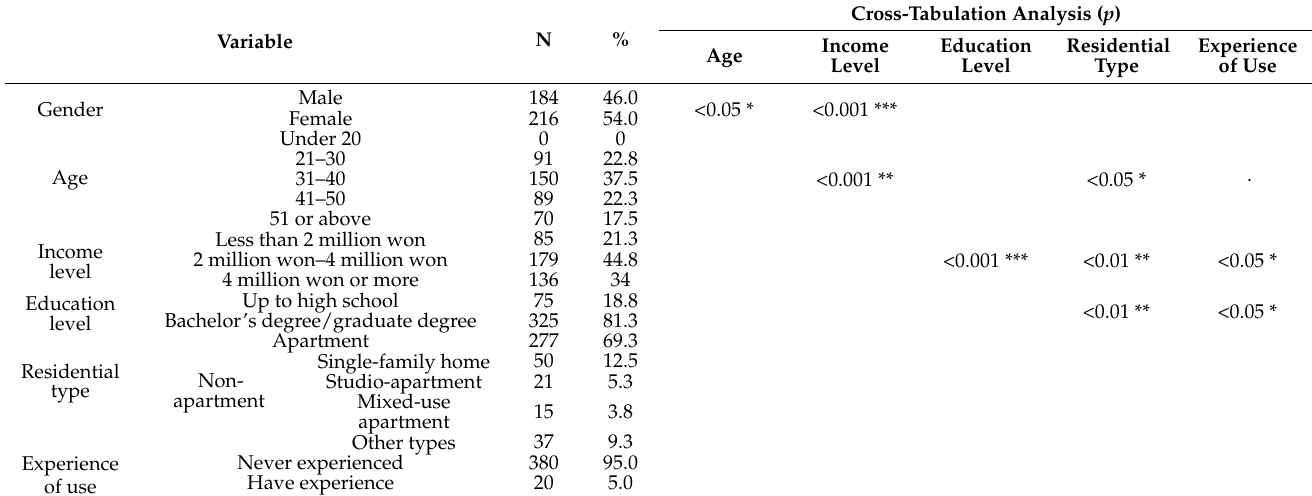
Table 2. Demographic characteristics of questionnaire respondents (N = 400, * p < 0.05, ** p < 0.01, *** p < 0.001). Variable